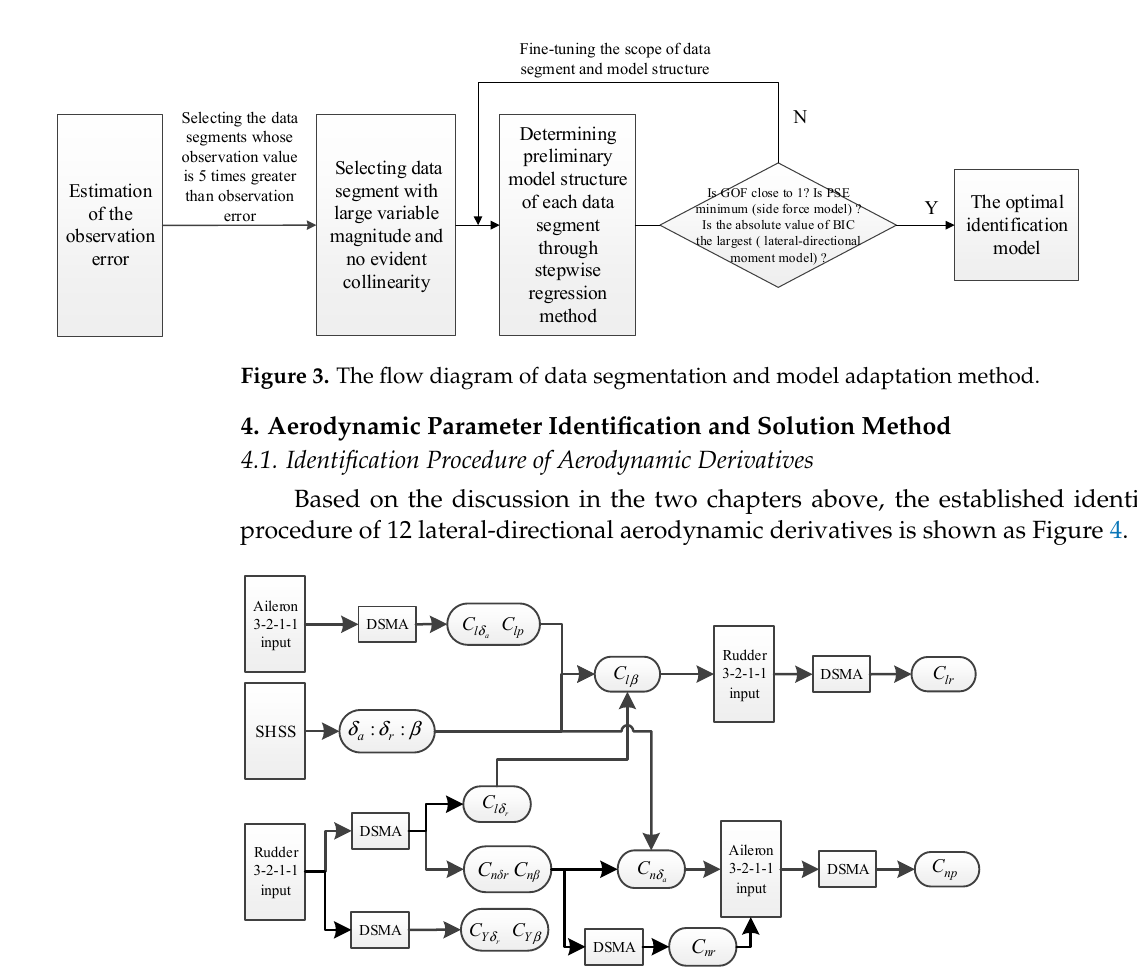
Figure 3. The flow diagram of data segmentation and model adaptation method.